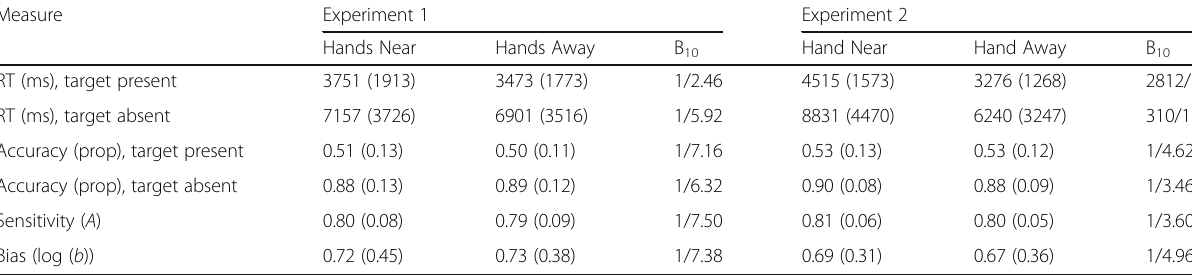
Table 1 Means, standard deviations, and Bayes factors (B 10 ) for each condition in Experiments 1 and 2